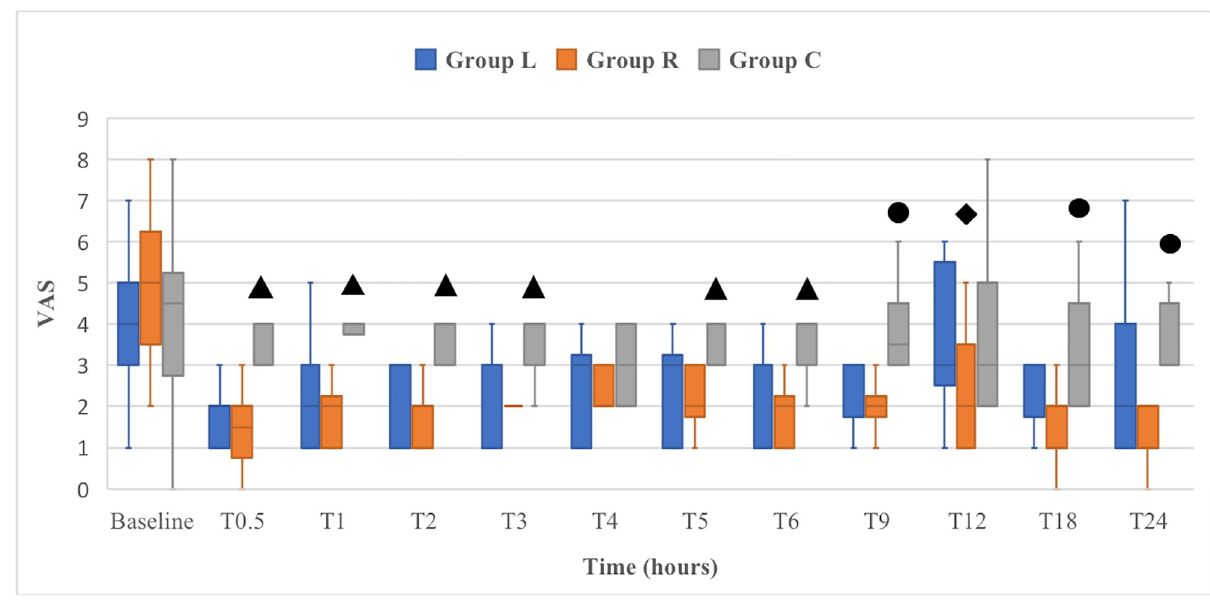
Fig 2. Box-and-whisker plots of the perioperative visual analogue scale (VAS) scores in 31 dogs undergoing major abdominal surgeries. Dogs received intraperitoneal and incisional lidocaine (Group L), ropivacaine (Group R) or sterile saline (Group C) at the end of surgery. Dogs were evaluated immediately before surgery (baseline) and from 30 minutes (T0.5) up to 24 hours (T24) after extubation. Each box represents the interquartile range, and the median value is the horizontal line within each box. The upper and lower whiskers represent the upper and lower range of values, respectively. ▲ : significantly higher than in groups L and R; ● : significantly higher than in group R; ◆ : significantly lower than in groups L and C.